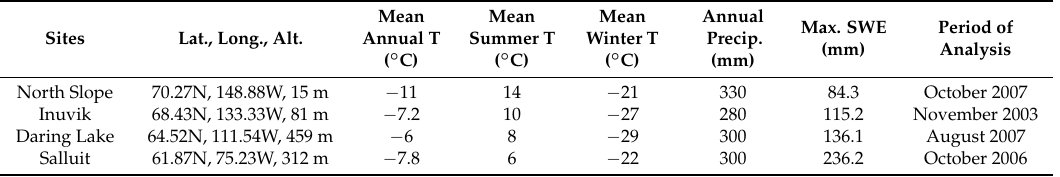
Figure 1. Map of study sites. From left (west) to right (east): North Slope, Inuvik, Daring Lake, and Salluit (see Table 1 for description). Base map: land cover map from [41]. Table 1. Details of study sites (see Figure 1): mean temperatures (T) (summer: June–August; winter: December–February), total precipitation, and snow water equivalent (SWE).